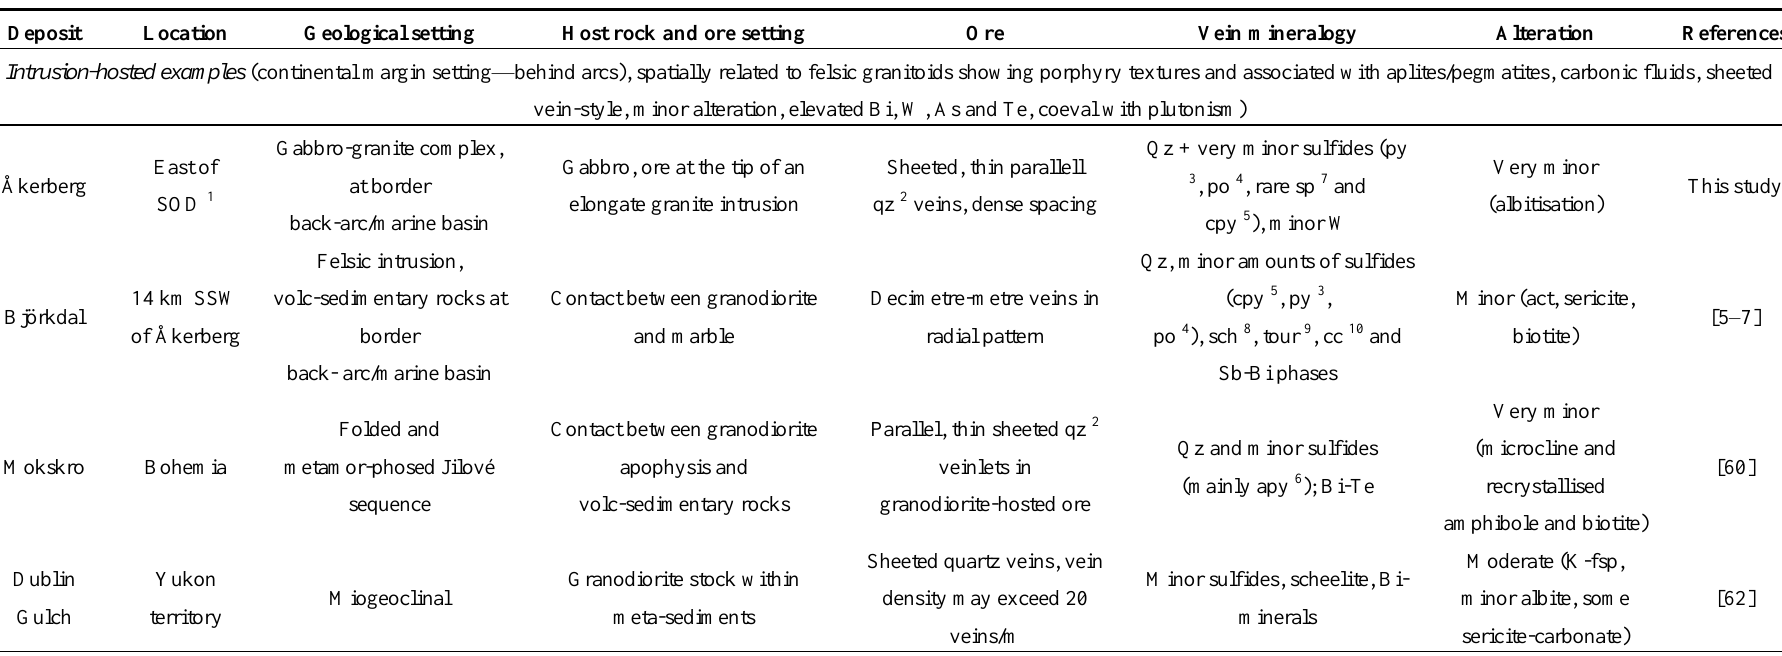
Table 3. Essential features of the Åkerberg gold deposit and a comparison with epigenetic gold deposits